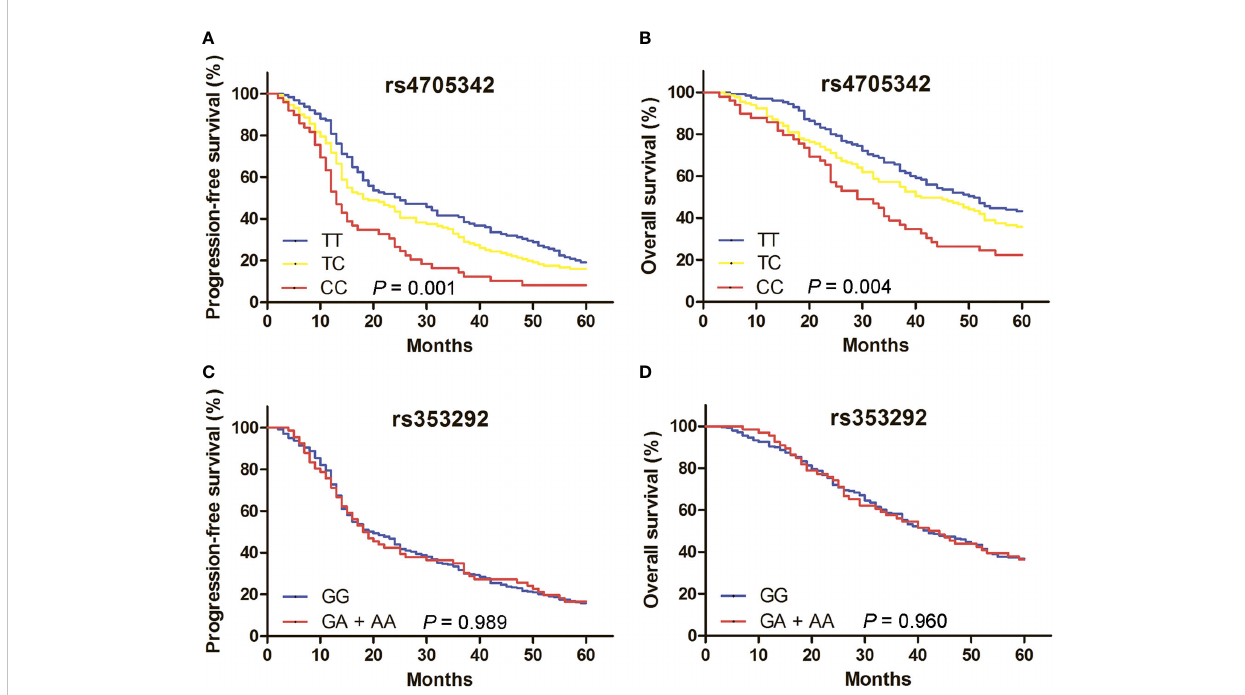
FIGURE 1 Kaplan-Meier survival curves evaluate the prognosis of 305 epithelial ovarian cancer (EOC) patients based on rs4705342 and rs353292 genotypes. (A) Median progression-free survival (PFS) of EOC patients carrying the TT, TC and CC genotypes of rs4705342 were 25.0, 18.0 and 13.0 months, respectively ( P = 0.001). (B) Median overall survival (OS) of EOC patients carrying the TT, TC and CC genotypes of rs4705342 were 51.0, 41.0 and 29.0 months, respectively ( P = 0.004). (C) Median PFS of EOC patients carrying the GG and GA + AA genotypes of rs353292 were 20.0 and 18.0 months, respectively ( P = 0.989). (D) Median OS of EOC patients carrying the GG and GA + AA genotypes of rs353292 were 42.0 and 42.0 months, respectively ( P =